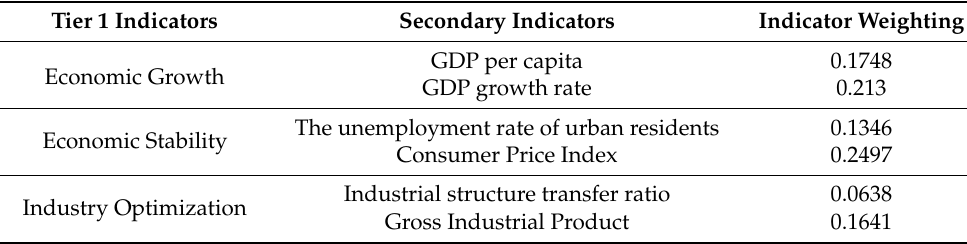
Table 11. Index weights calculated using the entropy value